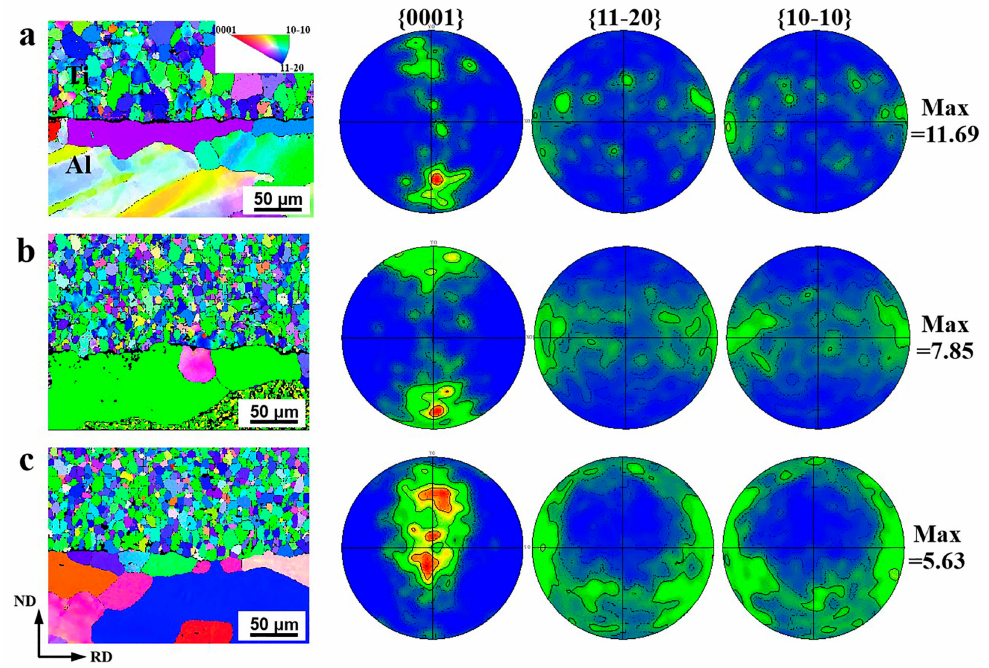
Figure 2. The inverse pole figures (IPF) and the pole figures (PF) of Ti layers in Ti/Al multilayered composites with ( a ) three layers, ( b ) five layers, and ( c ) seven layers along the RD-ND